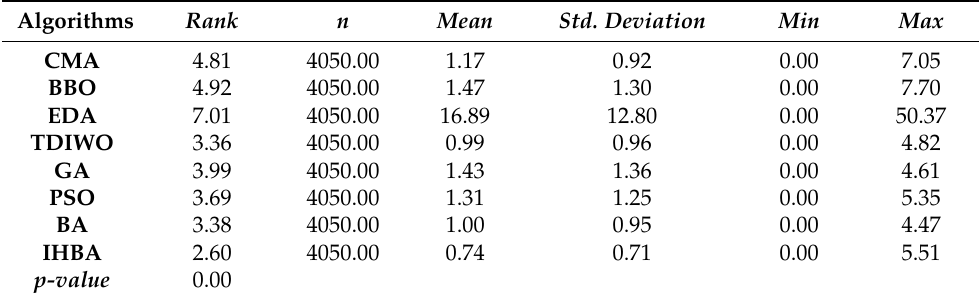
Table 5. The Descriptive Statistics Achieved by the Friedman Test at C =20 and α =0.05. The bold figures indicate the comparison between algorithms.